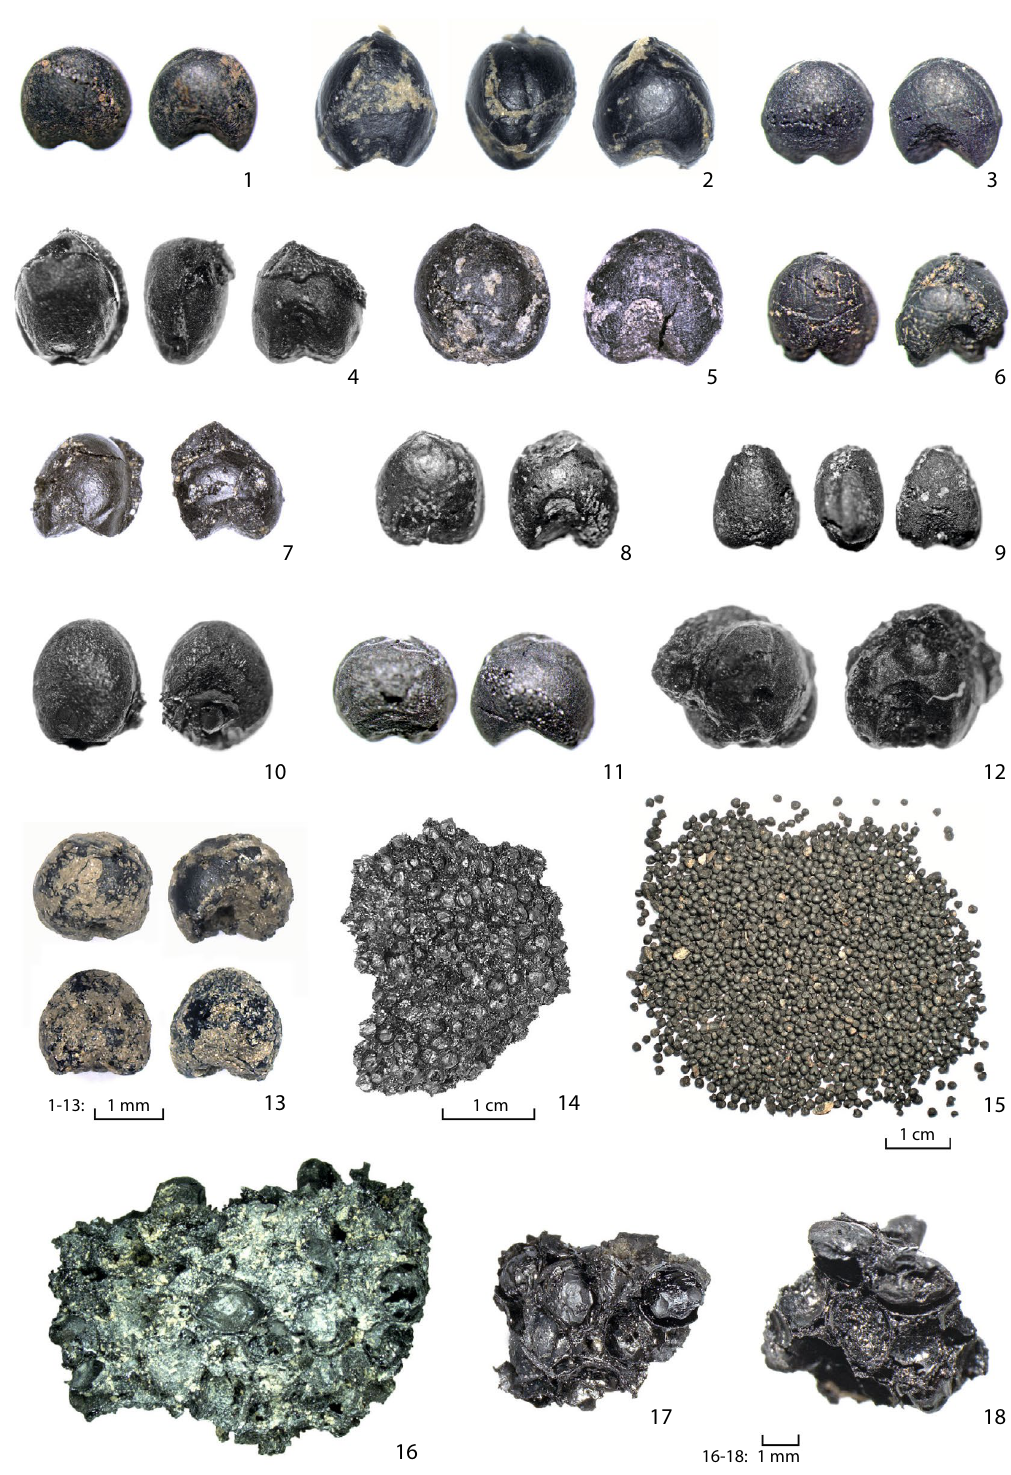
Figure 2. Examples of the dated loose and fused broomcorn millet grains from sites in Europe: (1) Altenrheine; (2) Vráble; (3) Pécel; (4) Teleac; (5) Ipf; (6) Binningen; (7) Königshofen; (8) Oštrovi; (9) Maszkowice; (10) Lavagnone; (11) Santa Giulia; (12) Soví převis; (13) Meidling-im-Thale; (14) Stillfried; (15) Wismar; (16) Custoza; (17) Hagnau; (18)